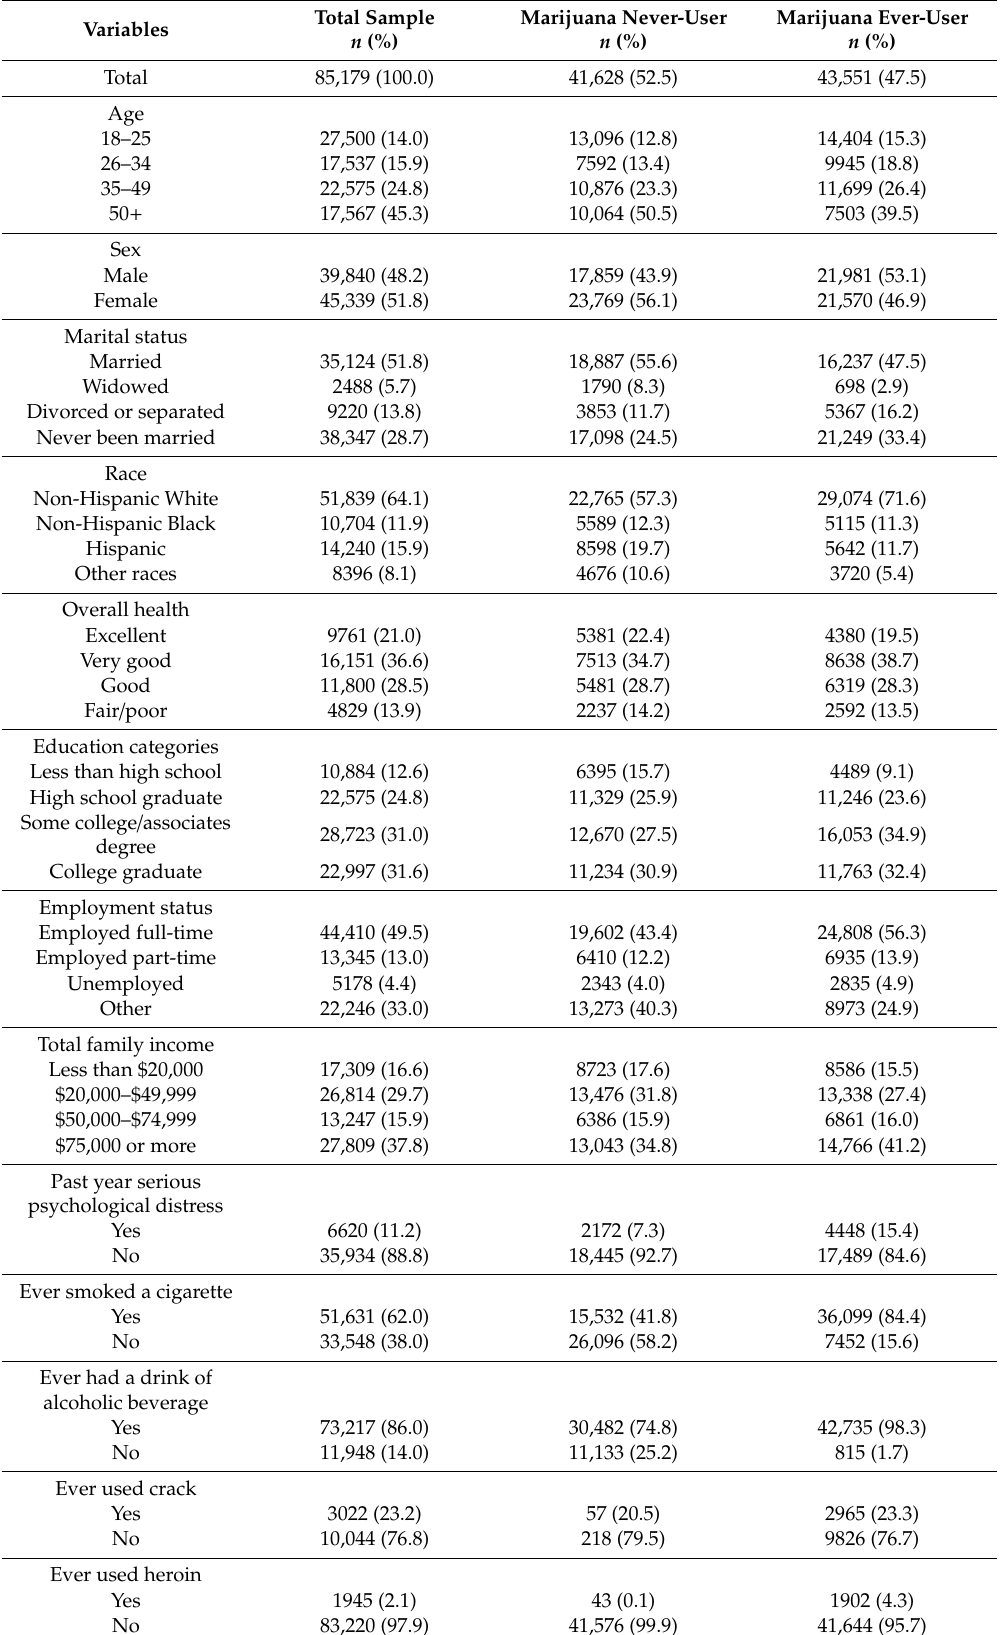
Table 1. Descriptive characteristics of U.S. population aged ≥ 18: data from the 2016–2017 National Survey on Drug Use and Health